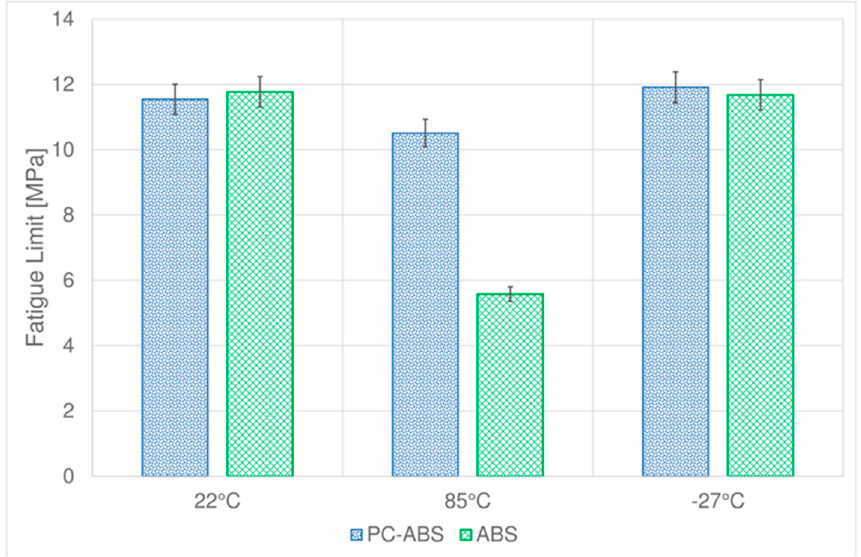
Figure 9. Comparison between fatigue limit of PC-ABS and ABS at different temperatures.